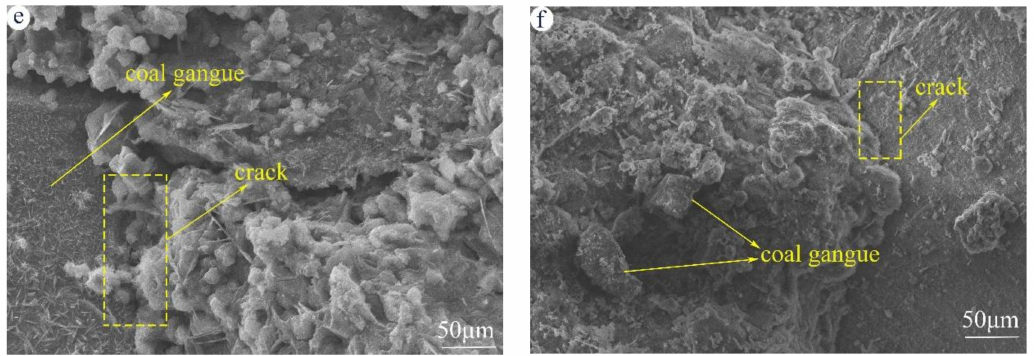
Figure 8. SEM images of AAC with and without metakaolin: ( a ) Con; ( b ) CGF5; ( c ) CGF10; ( d ) CGF20; ( e ) CGF30; and ( f )